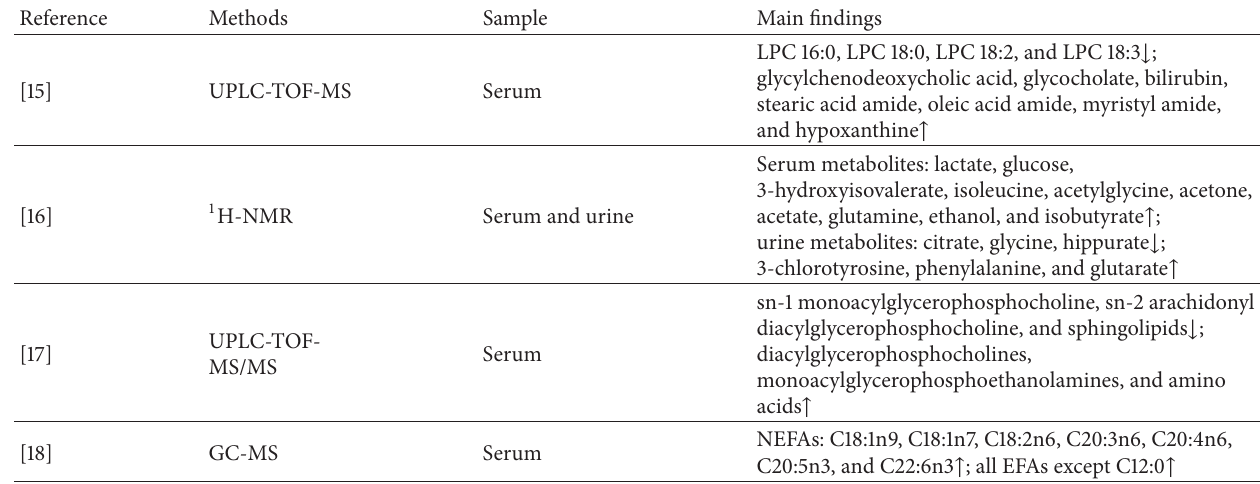
Table 1: The main information about clinical and experimental metabolomic studies on